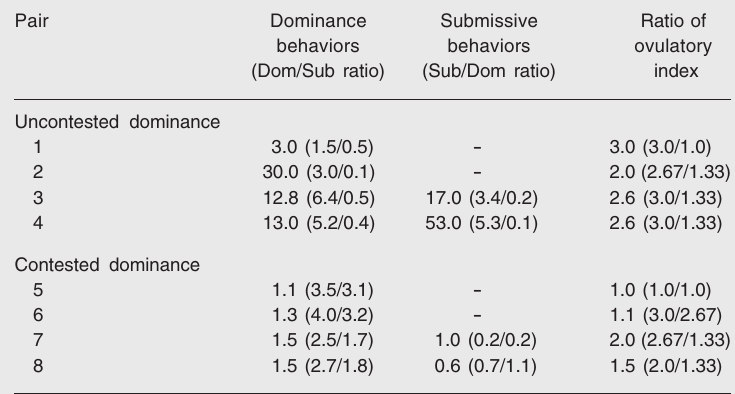
Table 2. Dominance ranking based on behavioral and hormonal